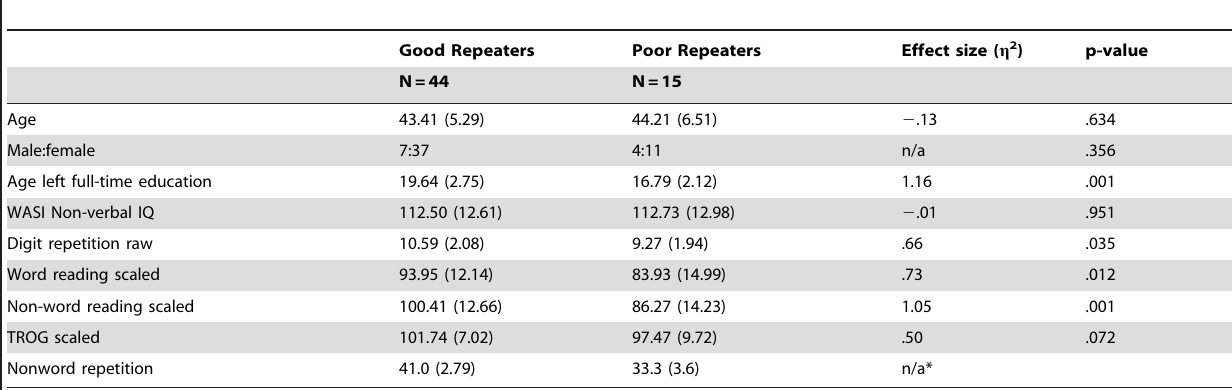
Table 1. Participant characteristics in relation to nonword repetition status such that ‘Good repeater’ refers to people with scores $ 37 and ‘Poor repeater’ refers to scores , 37.